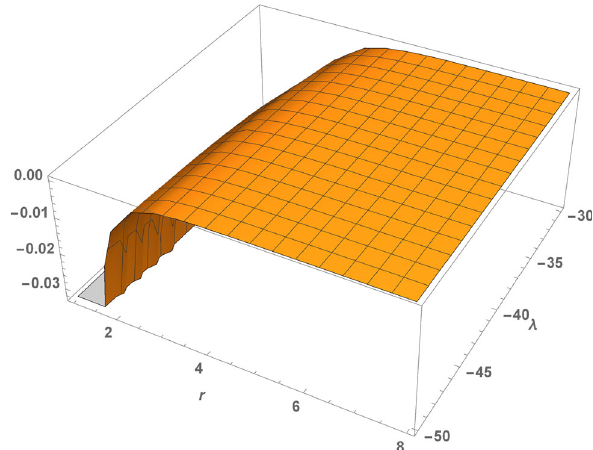
Fig. 7 NEC, ρ + p t ≥ 0, for α = 5 and different λ